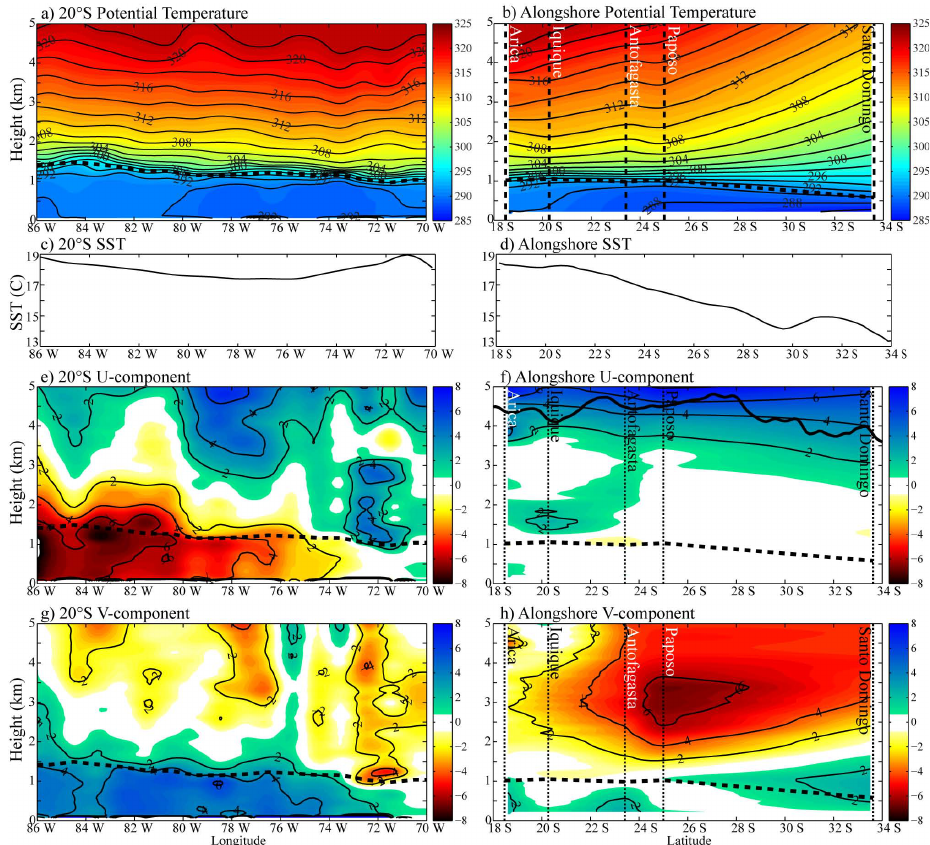
Fig. 6. Cross sections of soundings from the R/V Ron Brown along the 20 ◦ S transect (left column) and along the coast (right column). The variables are: (a, b) potential temperature (K), (c, d) satellite-derived SST ( ◦ C), (e, f) zonal wind (ms − 1 ), and (g, h) meridional wind (ms − 1 ). 20 ◦ S uses all available data (2001, 2003–2008) and alongshore uses 00:00 and 12:00UTC soundings from 15 October to 15 November 2008. In all panels, the thick dashed line shows the MBL mean depth. In panel ( f) the thick solid line show the smoothed maximum topographic